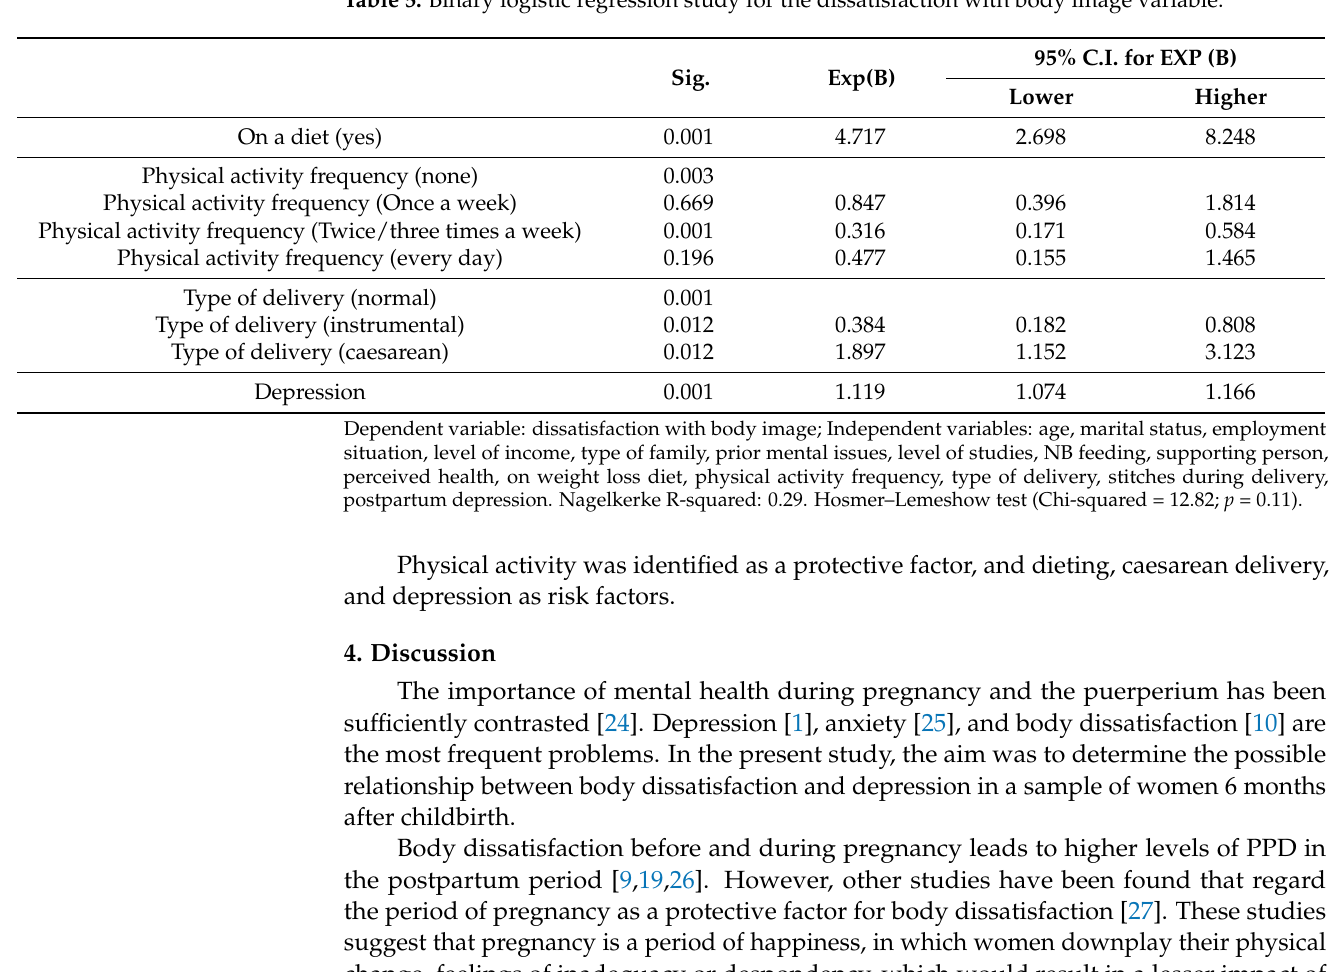
Table 5. Binary logistic regression study for the dissatisfaction with body image